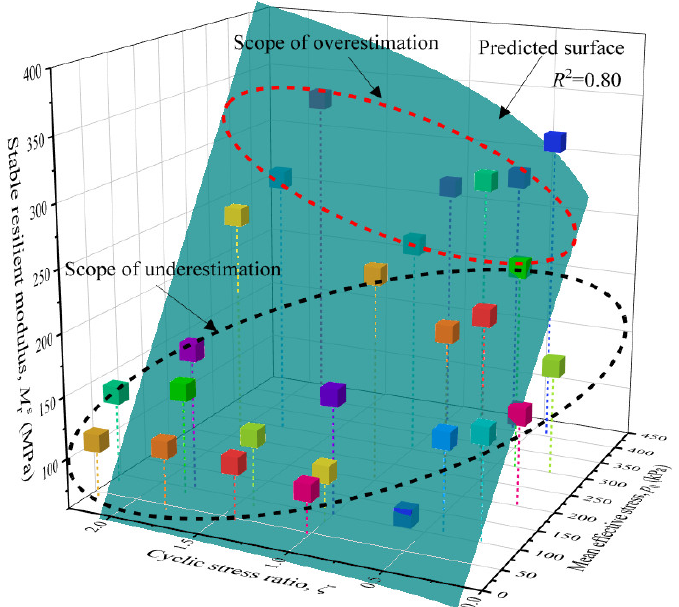
Figure 11. Predicted surface of stable resilient modulus calculated from Equation (14).